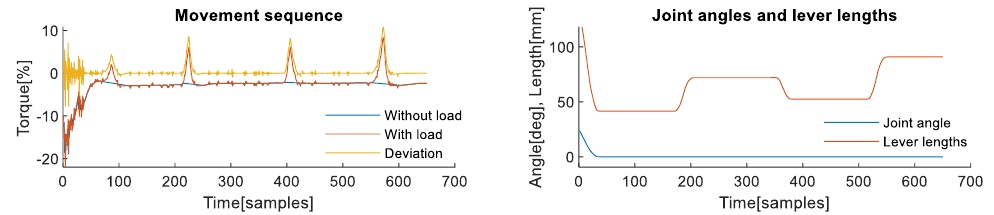
14 of 19 algorithm together with joint angles shown in blue on the right part of the same figure, has different dynamics compared to the corresponding signals analysed in the manipula-